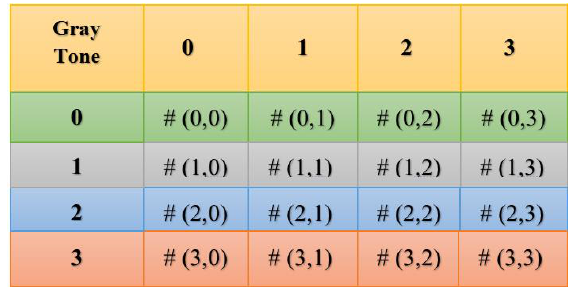
Figure 2. A generalized